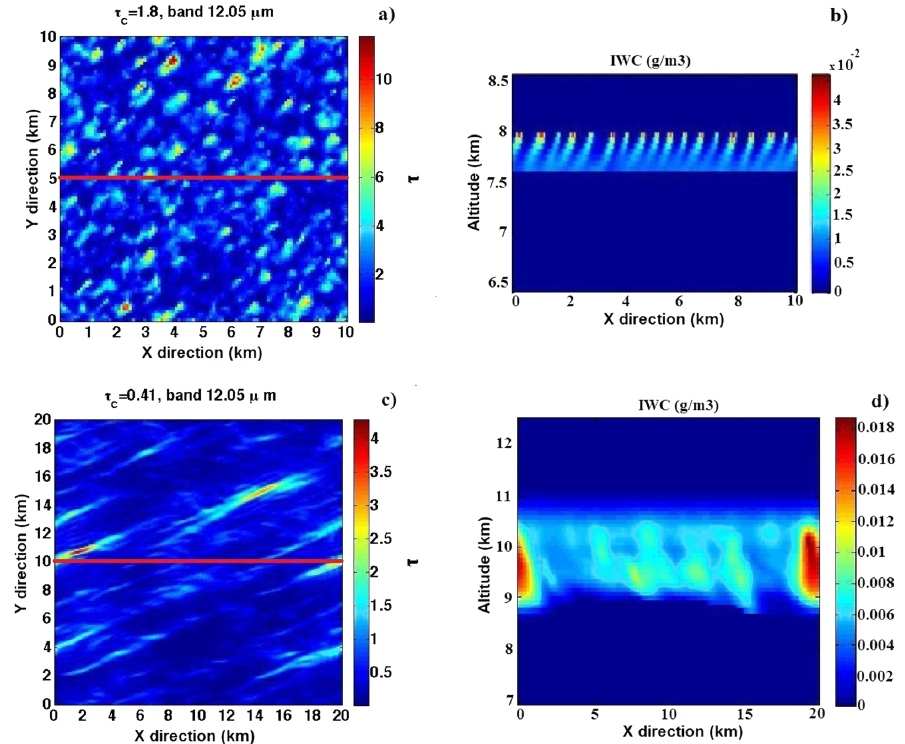
Figure 1. Top figures: Cirrus generated from realistic meteorological conditions (Starr and Cox, 1986; Hogan and Kew, 2005) with (a) the 10km × 10km optical thickness field simulated at 12.05µm with a horizontal spatial resolution of 100m and (b) the x – z view through the red line of (a) of the cirrus IWC with a vertical spatial resolution of 58m. Bottom figures: CII cirrus simulation based on optical and microphysical properties of the cirrus observed during the CIRCLE-2 campaign on 25 May 2007: (c) the 20km × 20km optical thickness field at 12.05µm, with a horizontal spatial resolution of 100 m and with a mean optical thickness τ c = 0 . 41 observed by IIR at 12.05µm, and (d) the x – z view through the red line of (c) the cirrus IWC with a vertical resolution of